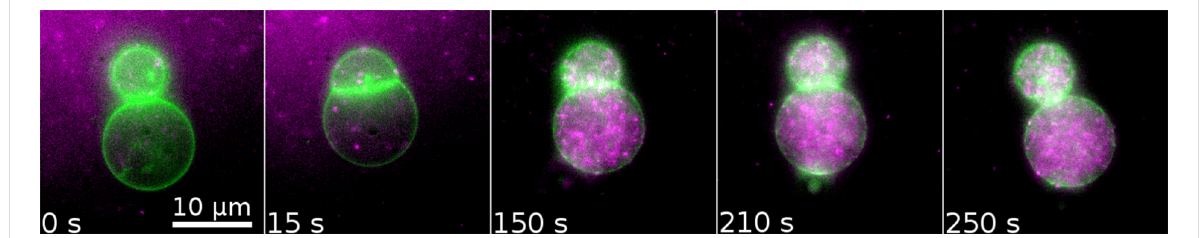
Figure 5: Time series of two DOPC vesicles in close contact. Upon the uptake of particles, initially a sudden, strong adhesion is induced, followed by a successive return to spherical shape. At 15 s the maximum adhesion area is achieved.